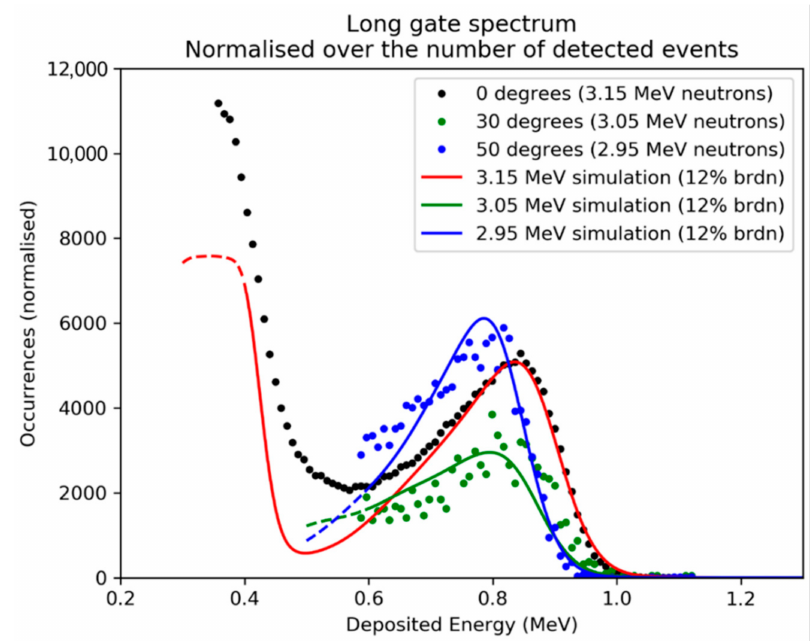
Figure 6. Deposited energy spectra for three different neutron energies at the FNG (3.1, 3.05 and 2.95 MeV). The number of events is normalized. The three sets are compared to three GEANT4 simulations, simulating 3 × 10 8 monochromatic neutrons. The simulated spectra obtained were broadened through a Gaussian convolution with FWHM = 12% of the energy value, in order to emulate the detector’s energy resolution. Simulations are plotted as continuous lines and normalized to fit the data.